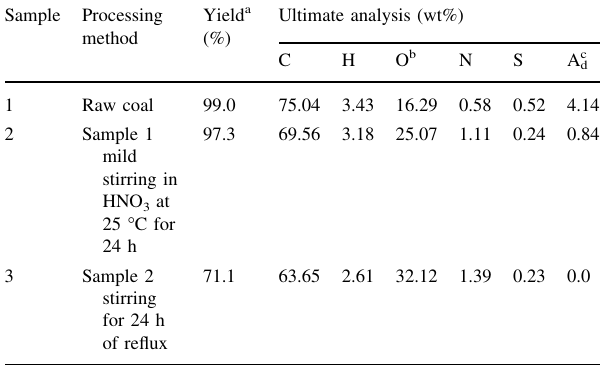
Table 1 Preprocessing results of WUCAIWAN coal in HNO 3